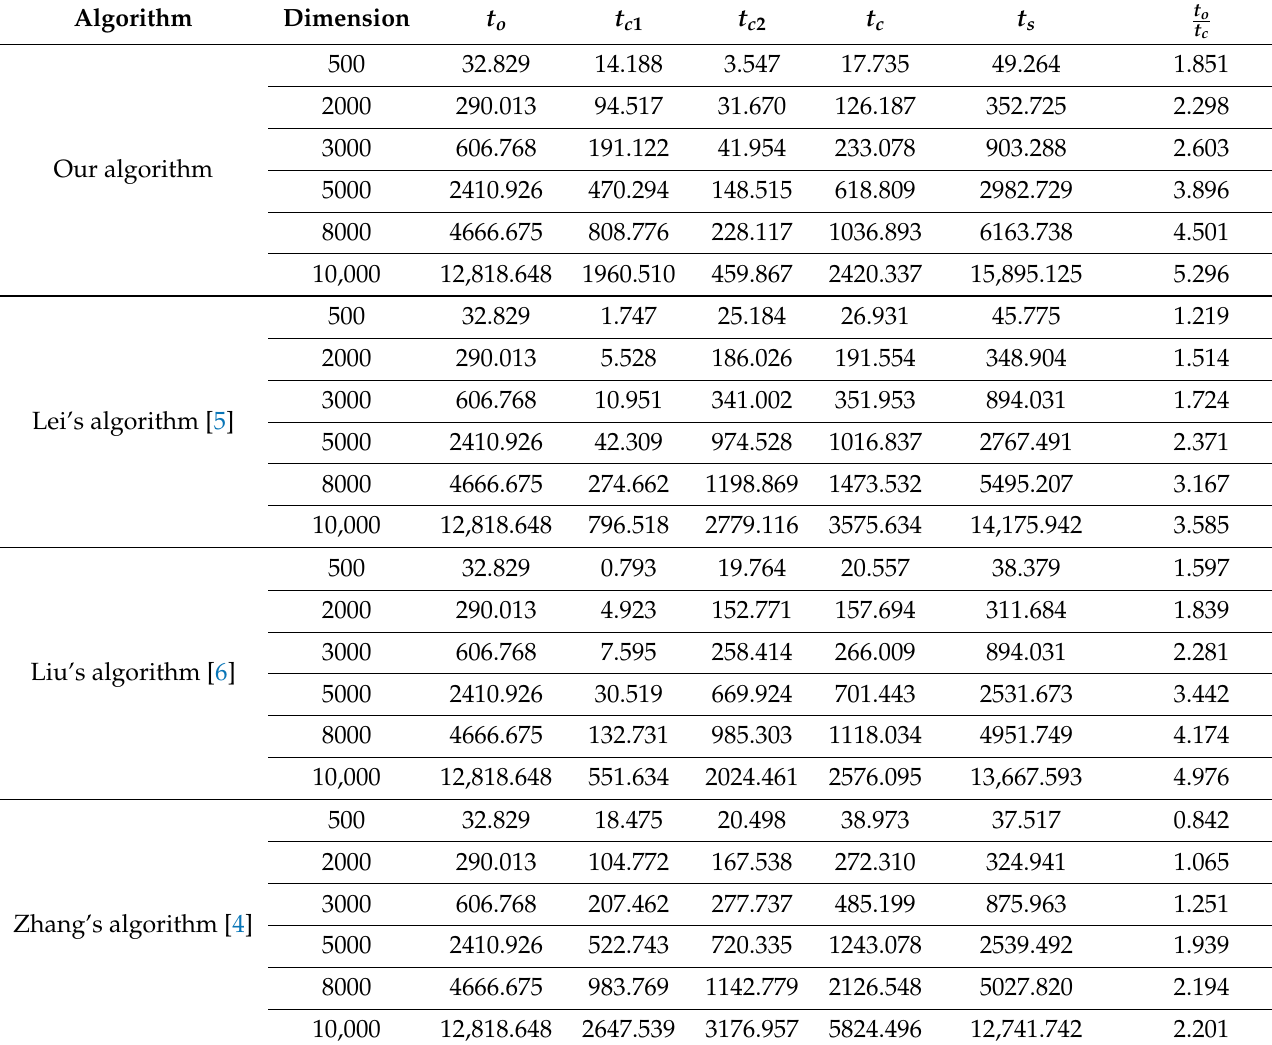
Table 8. Experimental results (time in